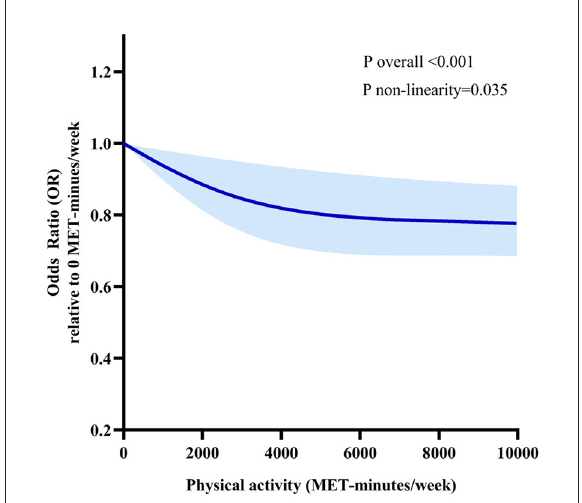
FIGURE1 Dose-response relationships between TPA and the risk of hypertension. Models are adjusted for age, sex, marital status, education, residency, smoking status, drinking frequency, sleep duration and annual income. The solid line and long dash line represent the estimated odds ratio and its 95% confidence interval. Knots are at the 25 th , 50 th and 75 th percentiles for